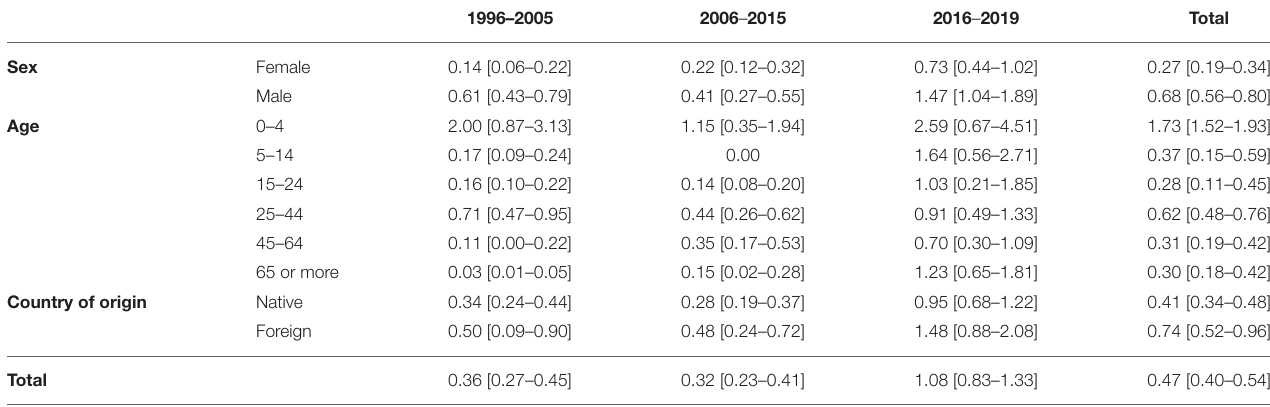
TABLE 2 | Incidence of leishmaniasis per 100,000 inhabitants and confidence interval (95%), by complete study time and periods 1996–2005 ( n = 55), 2006–2015 ( n = 52), and 2016–2019 ( n = 70),